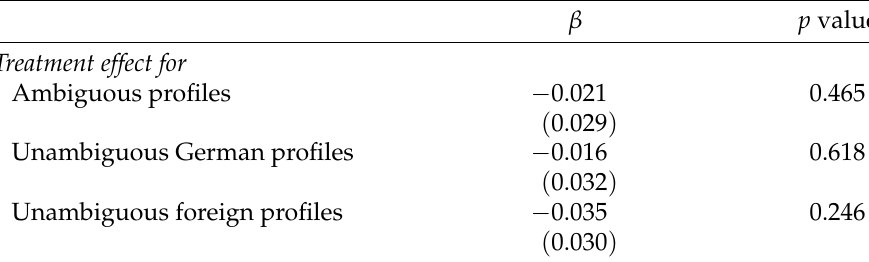
Table 2: Treatment effects on feelings toward natives and minorities